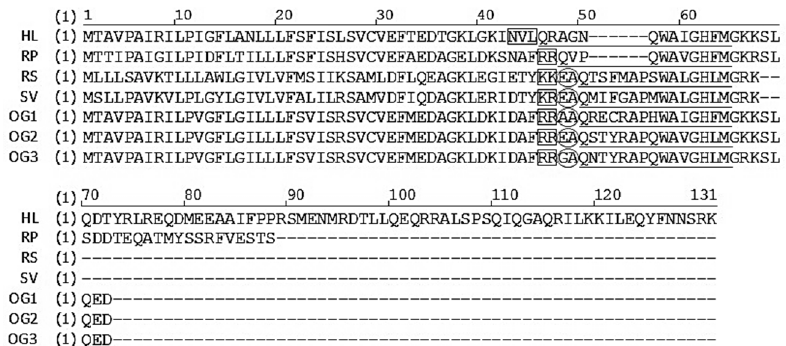
Figure 7. Sequence comparison of the precursors of bombesin-related peptides from different species of the Ranidae family. HL, Hylarana latouchii (this study); RP, Rana pipiens ; RS, Rana shuchinae ; SV, Sanguirana varians ; OG1-OG3, Odorrana grahami . The sequences of mature peptide are underlined. The processing sites of the precursor for releasing mature peptides are boxed. The second possible processing sites are circled in some sequences. Gaps are introduced to optimise the sequence homology.